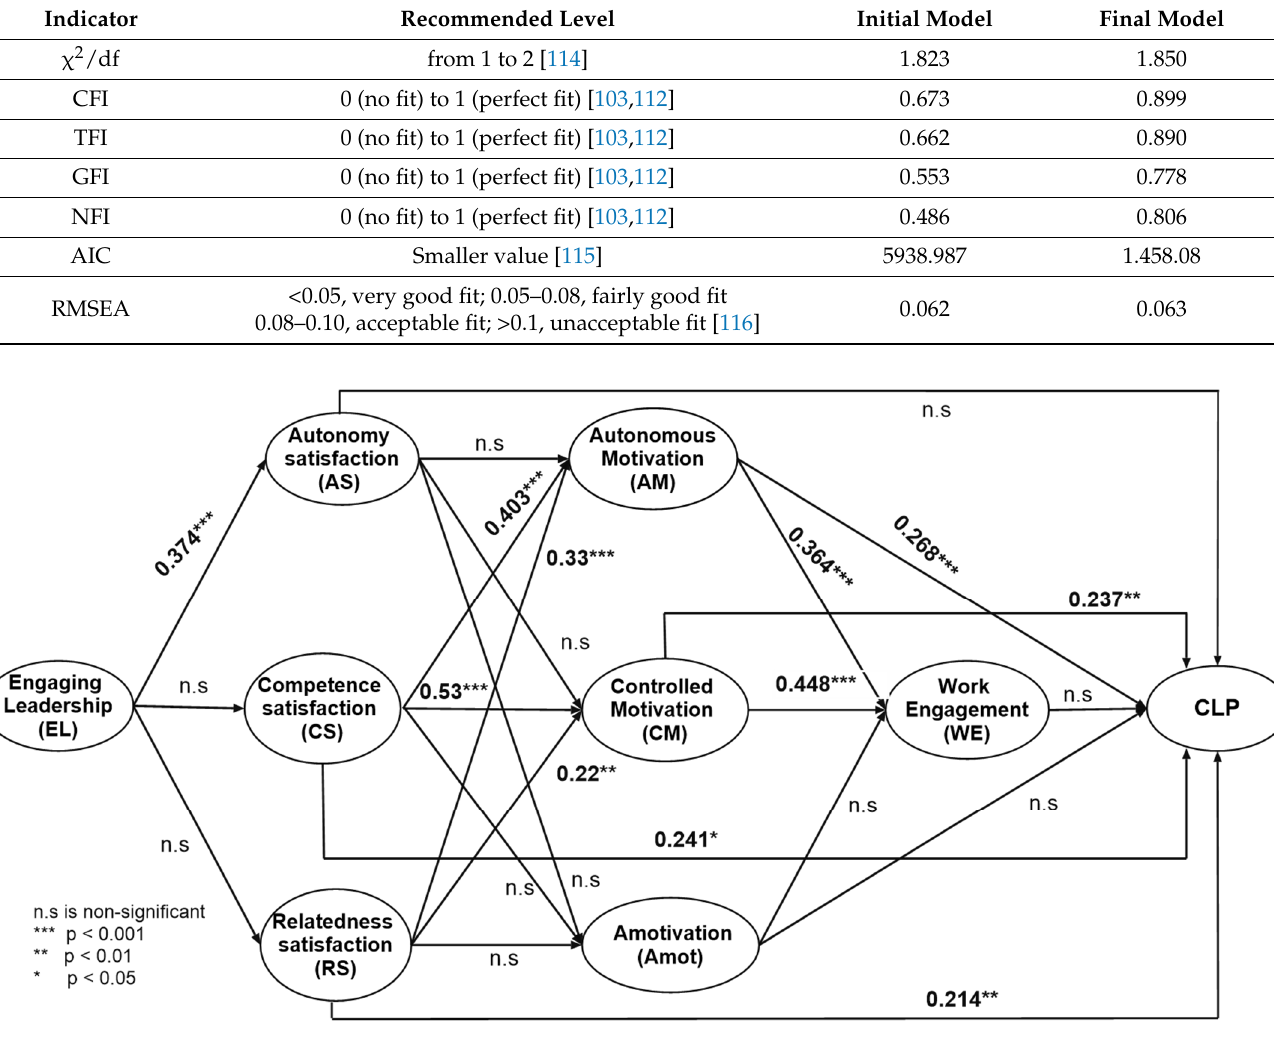
Figure 2. Regression weights for the final structural model.